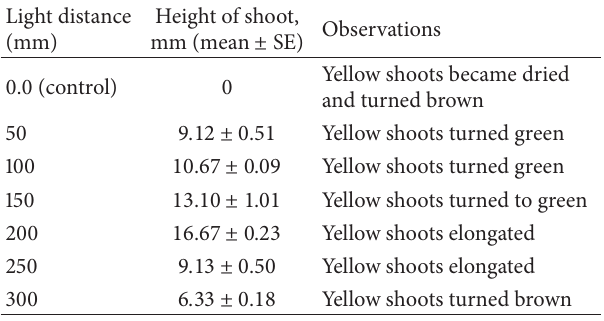
Each value represents the mean of thirty replicates. Mean ± standard error (SE), replicates ( 𝑛 = 30